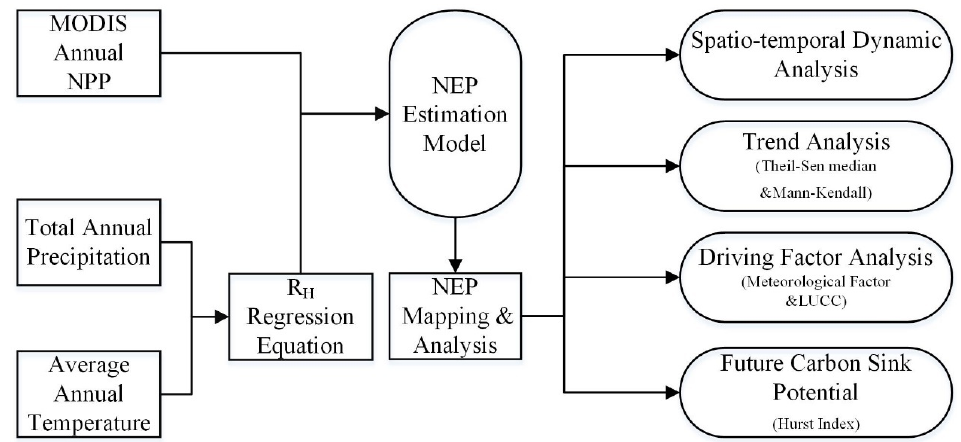
Figure 2. Research framework of spatiotemporal variation in carbon sources/sinks.